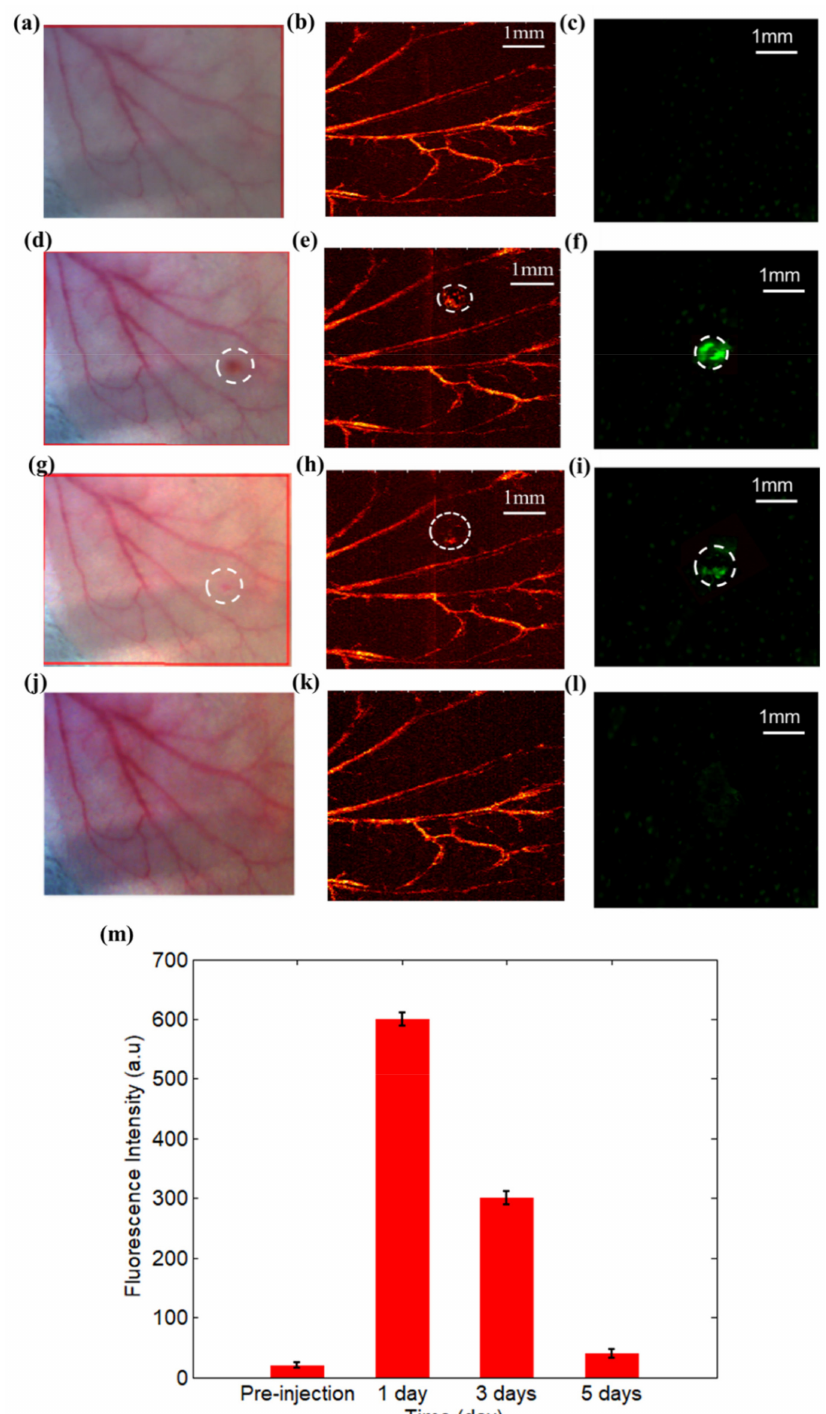
Figure 5. Dual-modal PAM and fluorescence microscopy imaging for monitoring the inflammation: ( a – c ) are the imaging results before the injection of bacteria; ( d – f ) are the results at 1 day post-injection; ( g – i ) are the results at 3 days post-injection; ( j – l ) are the results at 5 days post-injection. The first column showed the picture of mice ear, the second one displayed the photoacosutic image, whereas the third one exhibited the fluorescence image; ( m ) the corresponding fluorescence intensity at pre-injection, 1 day, 3 days, and 5 days post-injection,